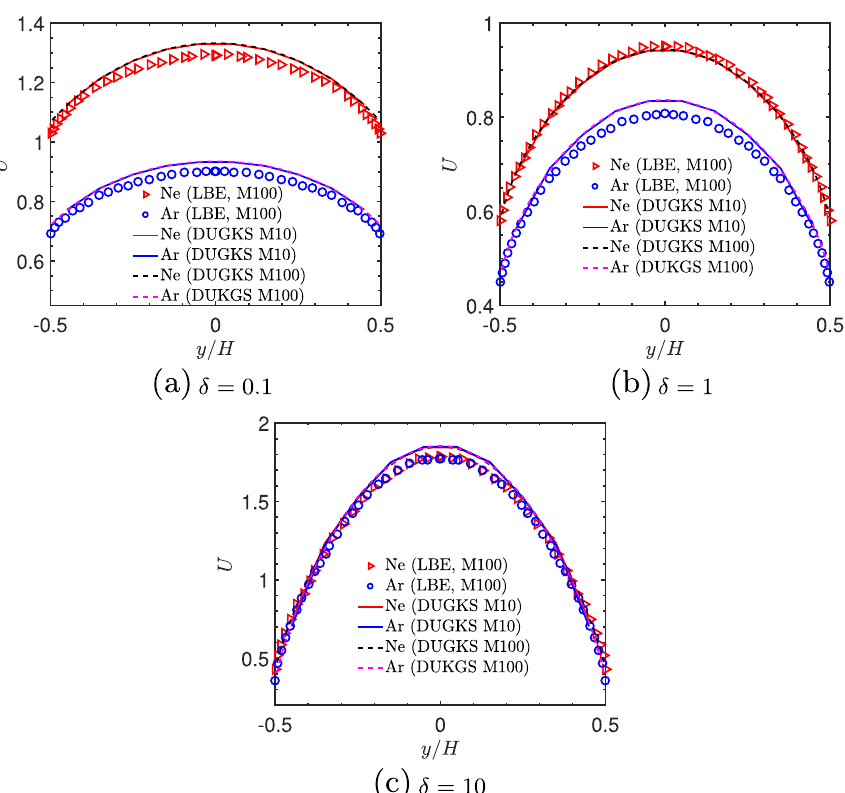
Fig. 16 Velocity profiles in the Poiseuille flow for an equimolar Ne-Ar mixture. M10 and M100 represent the results with 10 × 10 and 100 × 100 uniform mesh points in the physical space, respectively